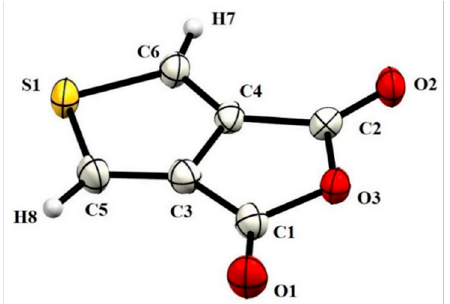
Figure 3. ORTEP (50% probability level) of the molecular structure of 4 with the atom-numbering scheme. Selected bond distances (Å), angles ( o ) and torsion angles ( o ): S1–C5 = 1.722(2), S1–C6 =